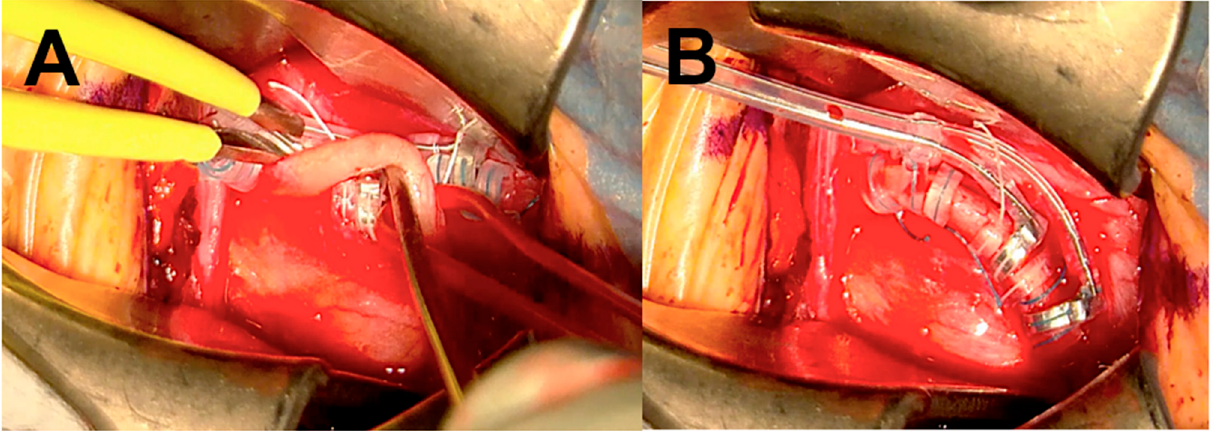
Figure 6. Resection of an intraspinal, lumbar hemangioblastoma with Aeos. Visualization of the arachnoidea and spinal cord after dura opening during surgery in ( A ). Exposure of the underlying intradural tumor in ( B ).